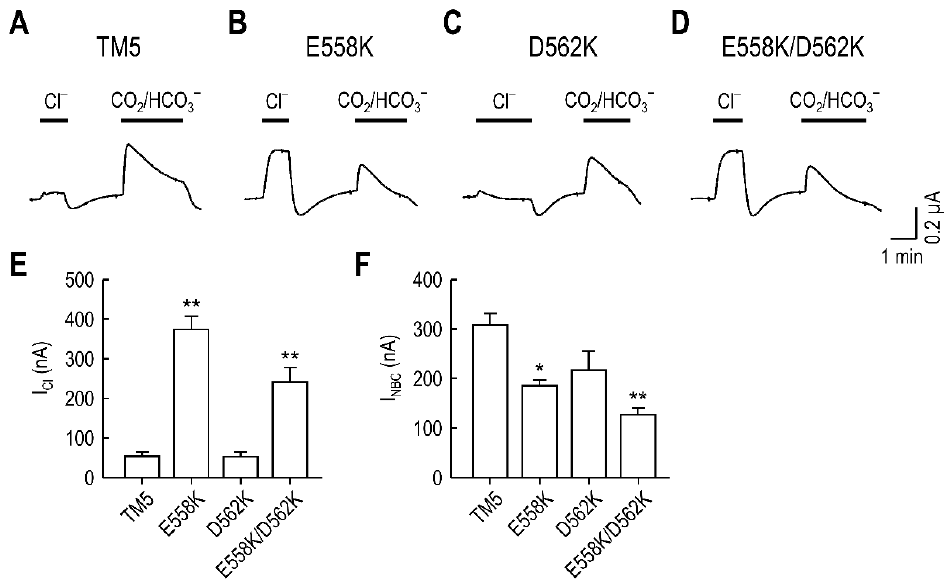
Figure 5. I Cl induced by Lys 558 replacement occurs without improving I NBC . ( A – D ) Representative I Cl and I NBC produced by the TM5 chimeric transporter ( A ), E558K ( B ), D562K ( C ), and E558K/D562K ( D ). I Cl and I NBC were recorded using the protocol described in Figure 1. ( E ) Mean I Cl produced by the mutants. The level of significance was determined using one-way ANOVA, with Sidak post-test ( n = 5–6/group). ( F ) Mean I NBC produced by the mutants. Peak currents after CO 2 /HCO 3 − application were measured. * p < 0.05 and ** p < 0.01 compared to TM5.